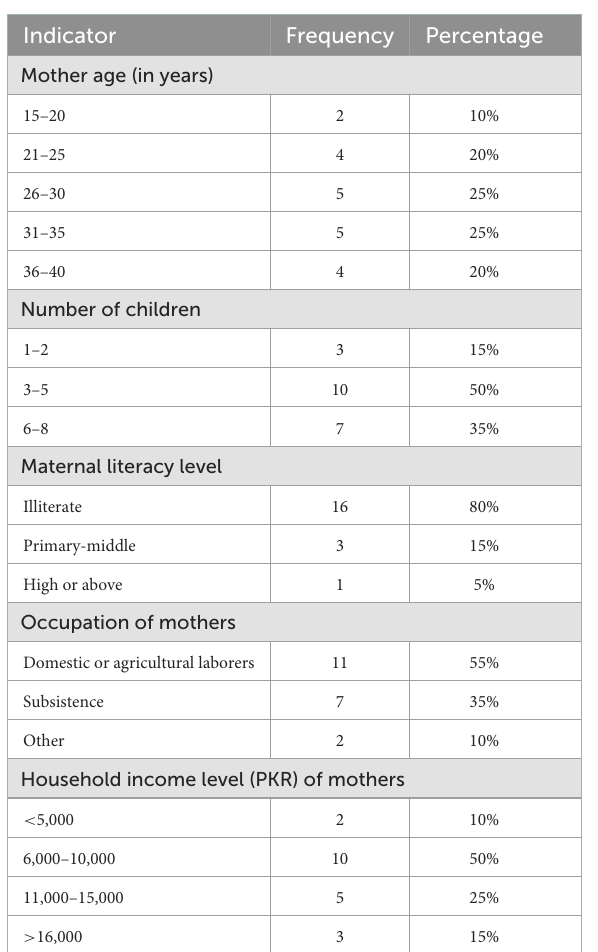
TABLE 2 Sociodemographic characteristics of mothers ( n =